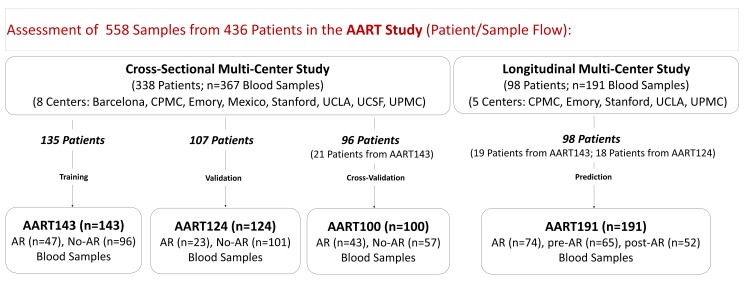
AART study design in 436 unique adult/pediatric renal transplant patients from eight transplant centers.558 PB samples from 436 adult and pediatric renal transplant patients collected from eight independent transplantation centers in the US, Spain, and Mexico were assessed. Emory, UCLA, UPMC, CPMC, UCSF, and Barcelona contributed adult samples, Mexico and Stanford, pediatric samples. For kSORT QPCR analysis, cross-sectional AART samples were divided into three cohorts: AART143, n = 143 adult samples from 135 patients for kSORT gene modeling; AART124, n = 124 independent adult (n = 59) and pediatric (n = 65) samples from 107 adult (n = 52) and pediatric (n = 55) patients (for independent kSORT validation); AART100, n = 100 adult (n = 78) and pediatric (n = 22) samples from 96 adult (n = 75, of which 21 patients were also included in AART143) and pediatric (n = 21) patients for final kSORT assay lock and clinical translation. For kSORT QPCR analyses, longitudinal samples were included in AART191: n = 191 adult (n = 94) and pediatric (n = 97) serial samples from 98 adult (n = 58) and pediatric (n = 40) patients for kSORT prediction. Detailed demographic patient information is shown in Table 1; detailed sample and patient flow is outlined in Table S2.